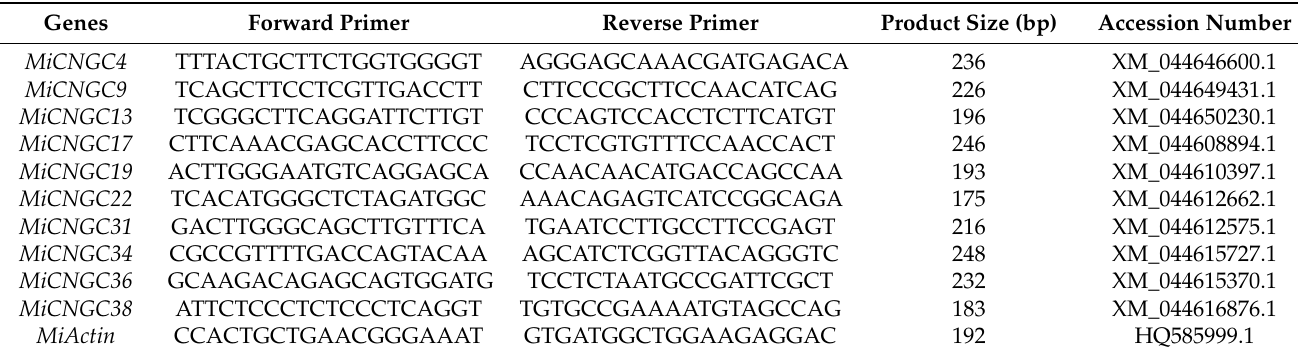
Table 2. Primers used for qRT-PCR analysis.